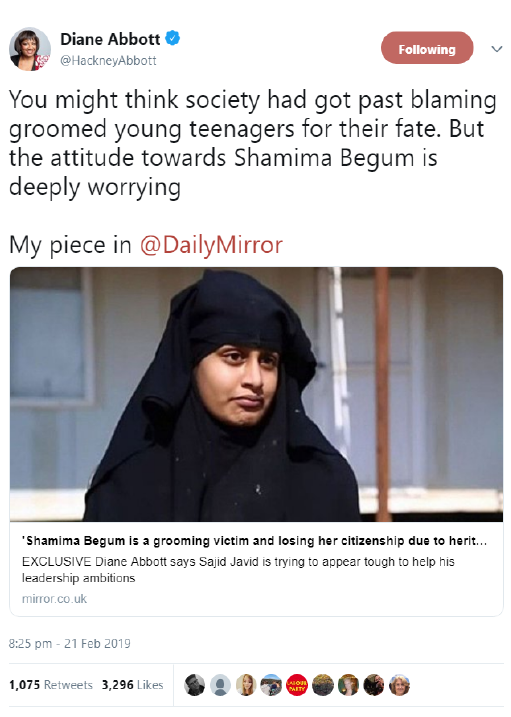
Figure 2. Tweet from Shadow Home Secretary Diane Abbott, 21 February 2019.